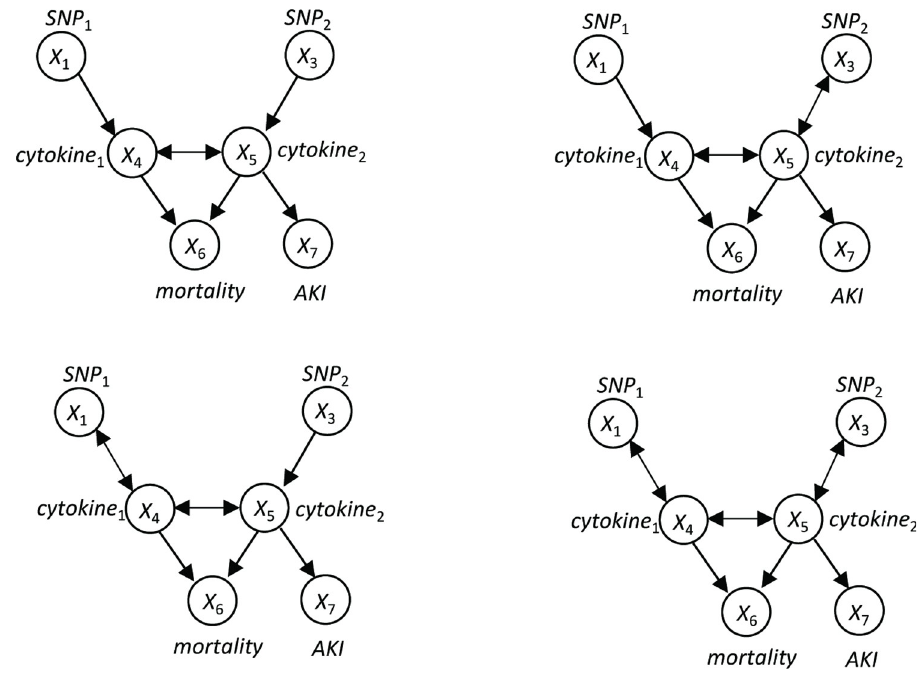
Fig 9. The MAGs consistent with the CBN shown in Fig 7, assuming pneumonia is an unmeasured variable.